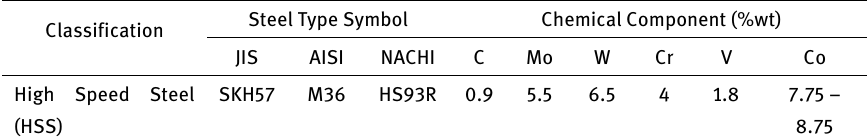
Table 2: Chemical Composition end mill cutter HSS-Co.